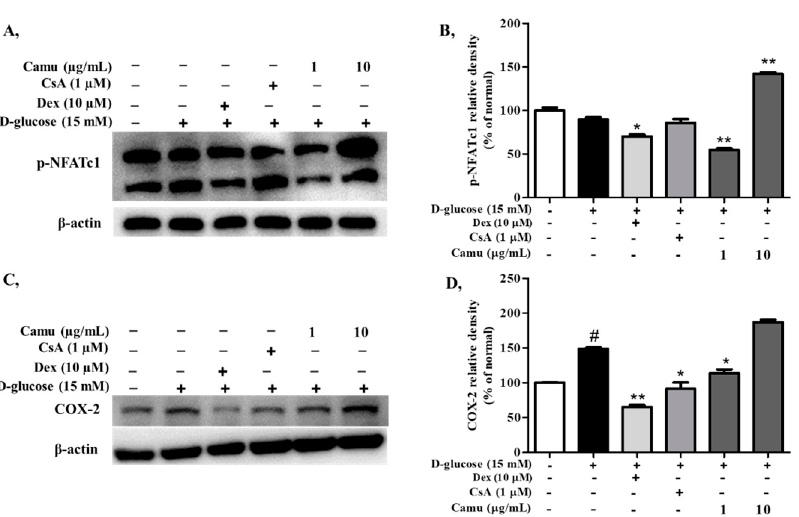
Figure 6. Effects of the camu-camu fruit on the NFATc1 and COX-2 signaling pathways in high glucose ‐ stimulated HaCaT cells. Phosphorylation of NFATc1 ( A ) and COX ‐ 2 ( C ) was evaluated by Western blot analysis. Band intensities for p ‐ NFATc1 ( B ) and COX ‐ 2 ( D ) were quantified using densitometry and normalized; the percentage was calculated on the basis of the level of β‐ actin. The data are shown as the means ± SD of three independent experiments. # Significant differences between the untreated group and the high glucose-induced group (# p < 0.05). * Significant differences between the high glucose ‐ induced group and the other groups (* p < 0.05; ** p < 0.01).